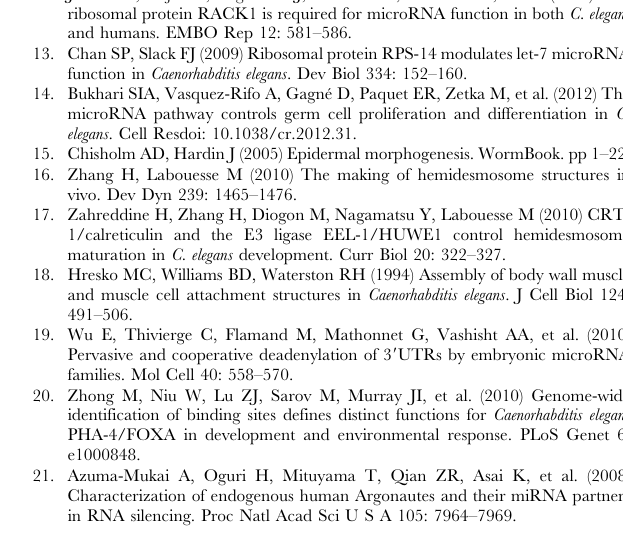
Figure S2 ALG-1 and ALG-2 expression profiles. GFP::ALG-2 and RFP::ALG-1 expression in head hypodermal cell (HH), tail hypodermal cells and tail neurons (TH,TN), body muscle cells (BM) and larval P cells whose lineage contribute to the neurons and body hypodermis (BH). Scale bar 20 m m. (TIF) Figure S3 Immunostaining of ALG-1 in adult C. elegans hermaphrodites. Staining with polyclonal antibody against ALG-1 of head organs. (A) A specific signal is detected in the pharynx of wild-type animals. (B) Staining of control alg-1(gk214) animal. (TIF) Figure S4 Detection of ALG-1 and GFP::ALG-2 in purified complexes. Detection of ALG-1 (A) and GFP::ALG- 2 (B) by Western blot analysis found in the immunopurified (IP) complexes from each developmental stage used for microRNA microarrays. 50 m g of the total protein (in) were run as controls. (TIF) Movie S1 Time-lapse analysis of the alg-2(ok304) ; alg- 1(gk214)/ + embryos. Movie from the time-lapse microscopy shown in Figure 7. The double mutant alg-2; alg-1 embryo is located at the bottom.